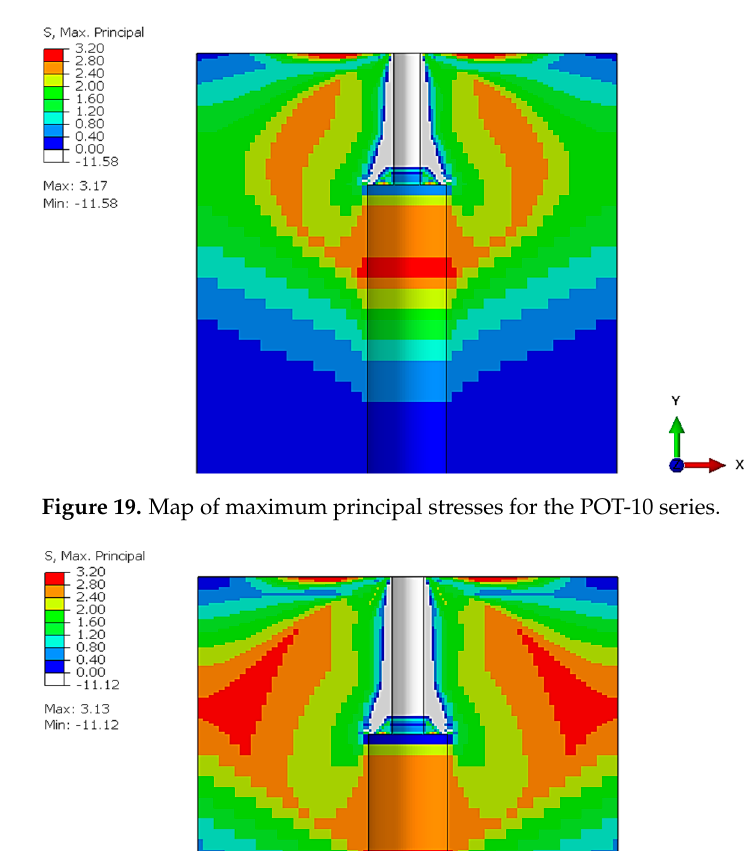
Figure 19. Map of maximum principal stresses for the POT-10 series.